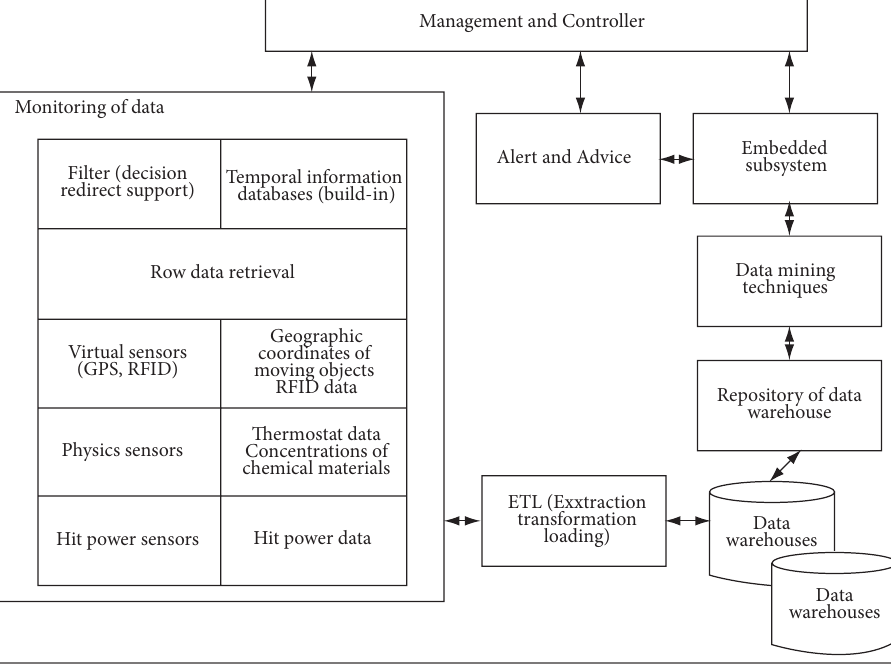
Fig. 1. Architecture of main components of the